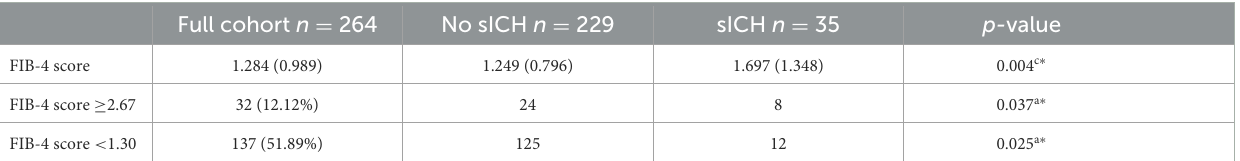
TABLE 2 sICH rates.